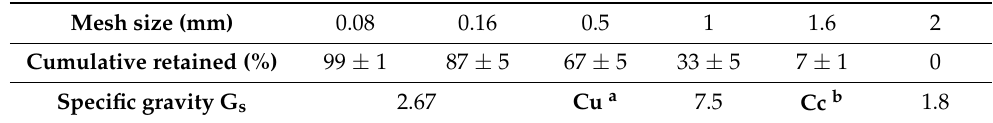
Table 2. Sand particle size distribution.